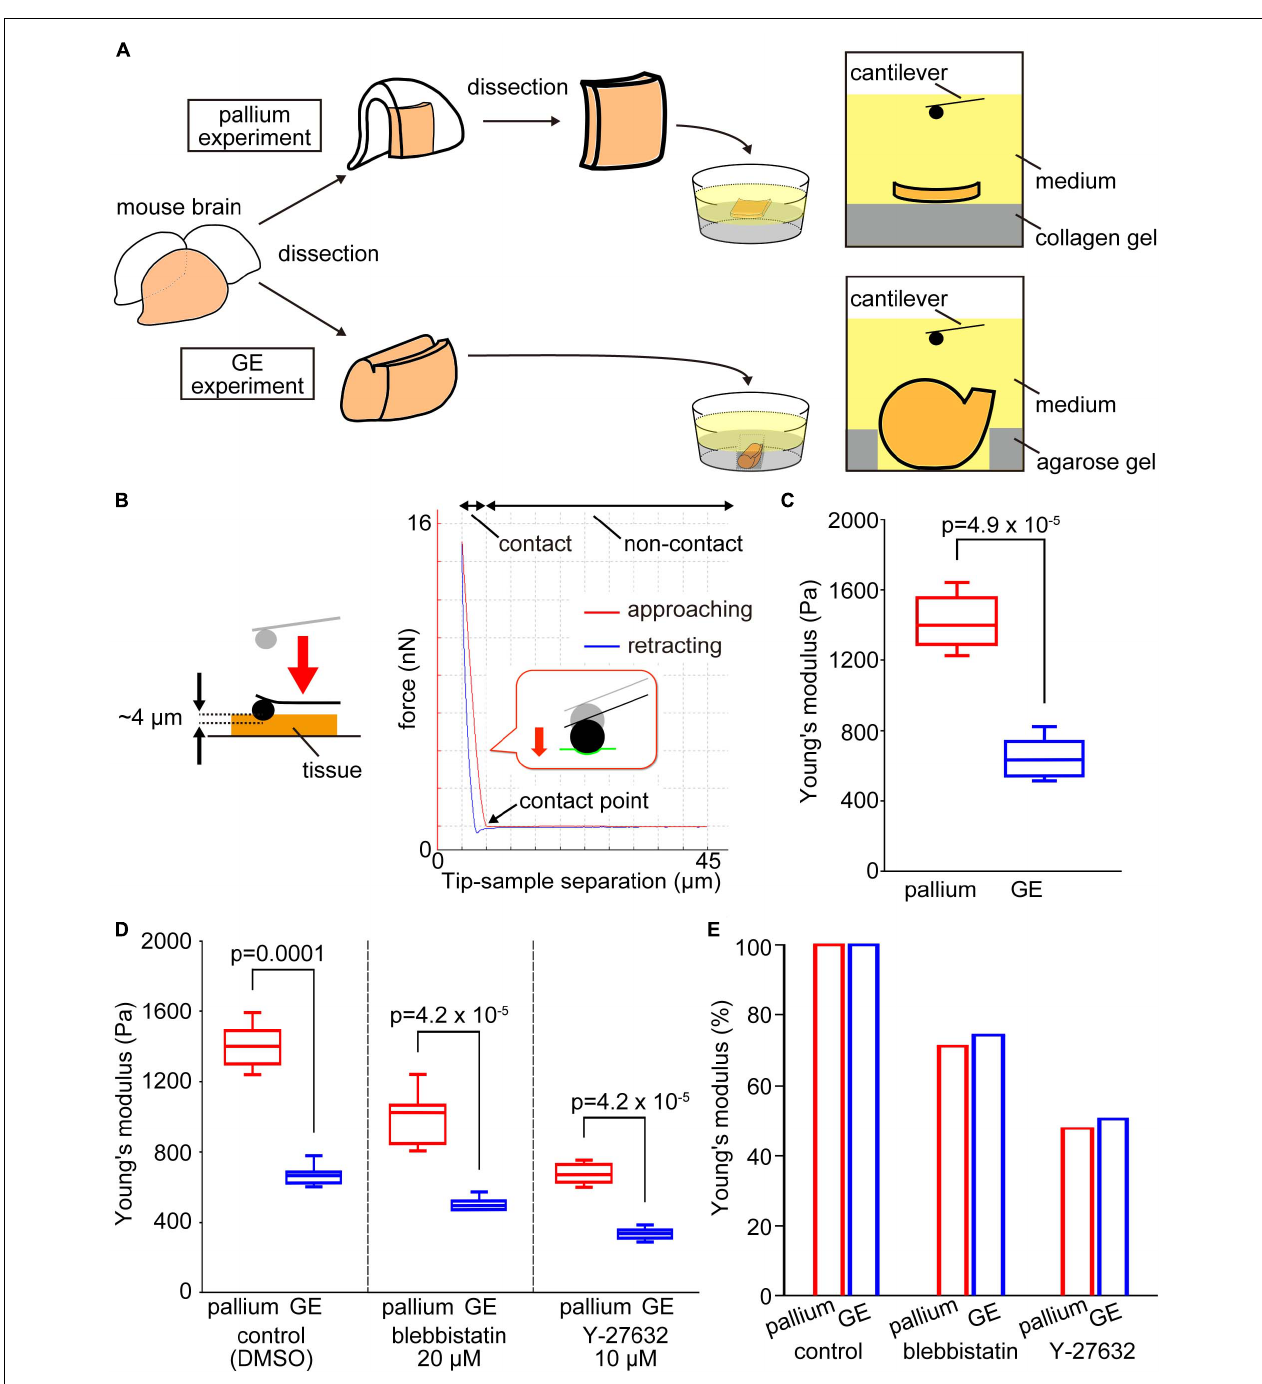
FIGURE 2 | Experimental design and results of atomic force microscopy (AFM) measurements on the apical surface of the pallium and the GE. (A) Schematic diagram of the experiments. (B) Illustration showing an AFM indentation measurement on the apical surface of tissue (left) and a typical force–distance curve obtained (right). In the AFM indentation measurement of elasticity, the cantilever approach to the sample (red line), made contact with it, and then retract (blue line). The elasticity is calculated from the slope of the force–distance curve at the contact area of the red line. (C) Graph showing that the Young’s modulus measured vertically on the apical surface was greater for pallium ( n = 11 pieces) than for GE ( n = 12 hemispheres) ( p = 4.9 × 10 − 5 , Mann–Whitney U -test). (D) Graph showing the results of AFM indentation experiments in the presence of actomyosin inhibitors that affect the apical surface. Young’s modulus was reduced by inhibitors in both pallium and GE, but the pallium > GE relationship was maintained. (E) Graph showing the pallium–GE resemblance for the Young’s modulus reductions under actomyosin inhibitor conditions.